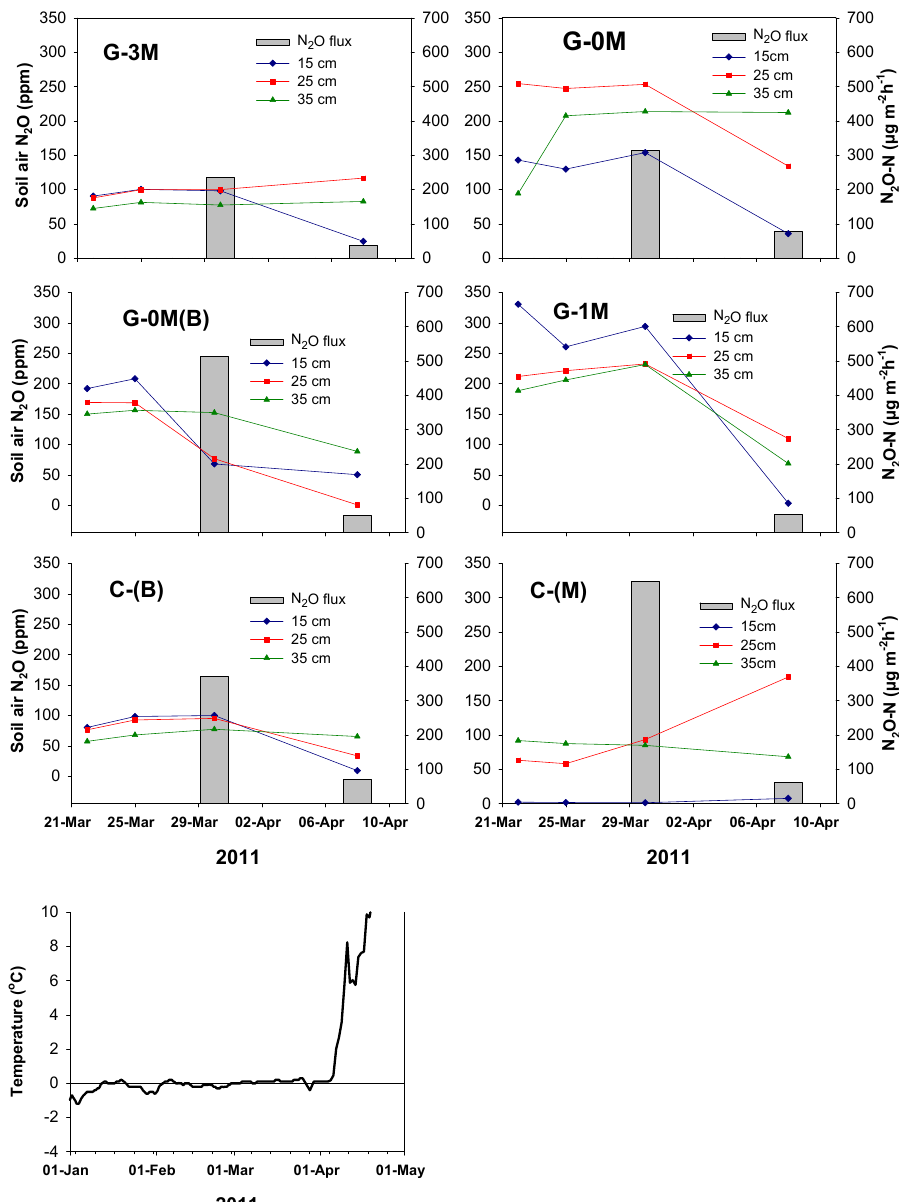
Fig. 4 Fig. 4. N 2 O concentration (ppmv) in soil atmosphere at three different depths (left y-axis) and N 2 O emission rates (right y-axis) during snow melt in 2011, as affected by different green manure management strategies in 2009 and 2010. Soil air N 2 O concentrations are average values from two replicate sets of soil air probes (3 depths). N 2 O emission rates are the average of four replicates. Soil temperature was calculated as a weighted mean of soil temperature readings in 5 and 20cm